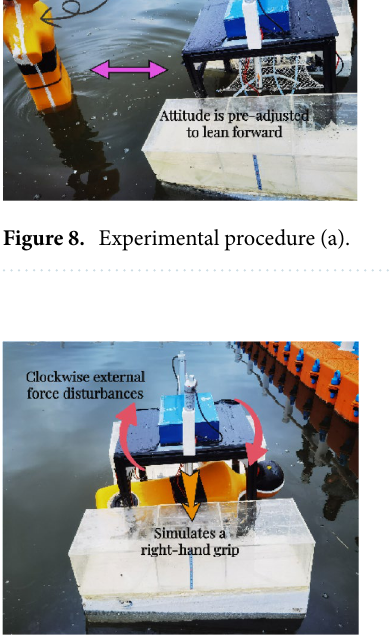
Figure 9. Experimental procedure (b).